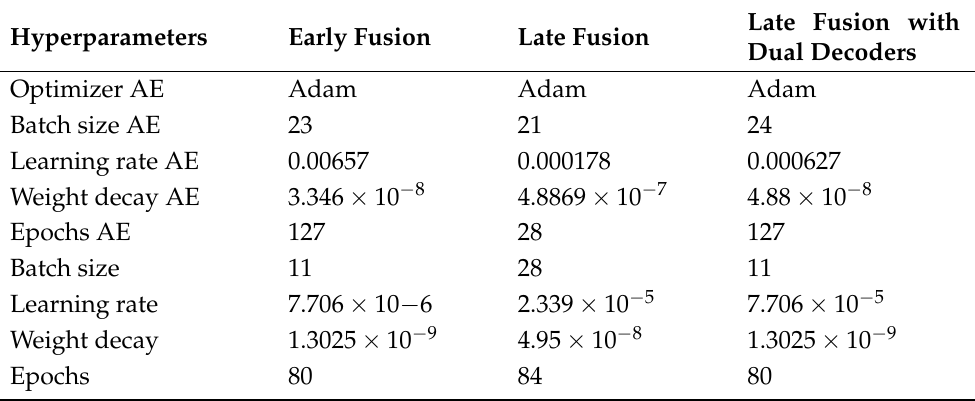
Table A1. List of hyperparameters used for training the fusion techniques for multi-perspective anomaly detection on our multi-perspective dices dataset (without augmentations). AE refers to the autoencoder from the pre-training